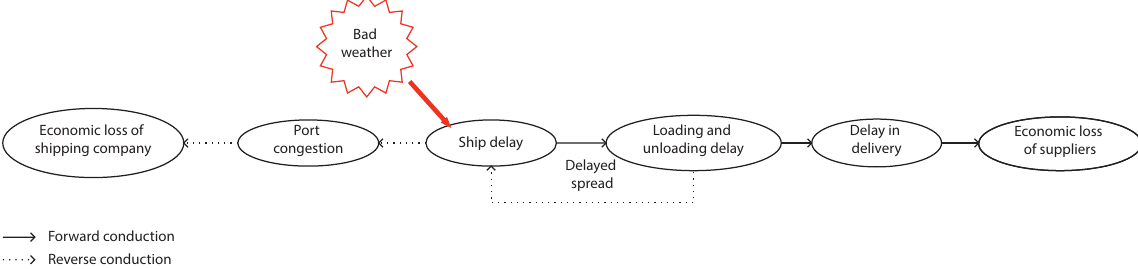
Figure 2: Example of chain propagation under sudden severe